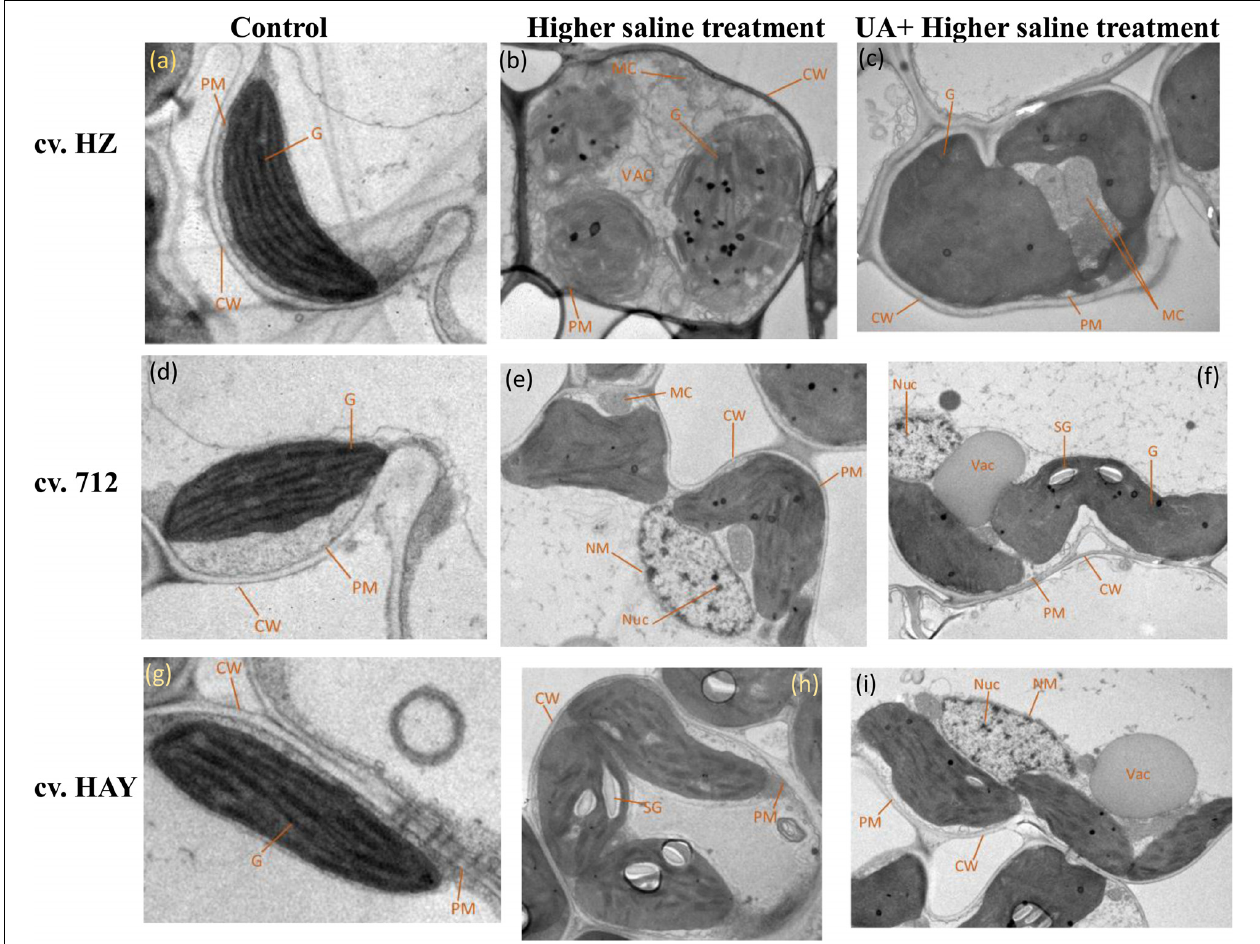
FIGURE 5 | Electron micrographs of leaf mesophyll cells of three rice cultivars (cvs. HZ, 712, and HAY) under Control (A,D,G) , S2 = 8 dSm − 1 (B,E,H) , UAS2 = Ursolic acid + 8 dS m − 1 (C,F,I) treatments. PM represents the plasma membrane, G represents the grana, CW represents the cell wall, MC represents the mitochondria, VAC represents the vacuole, NM represents the nuclear membrane, NUC represents the nucleus, and SG represents the starch grain. The experiment was repeated three times with similar